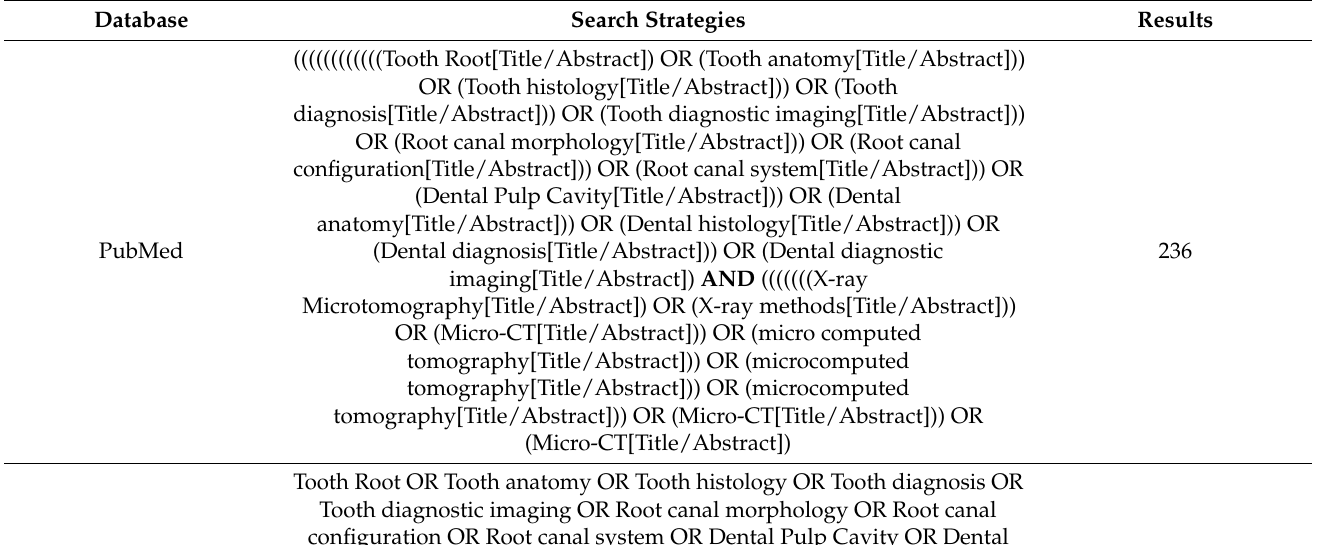
Table 1. Information of sources and search strategies using MeSH